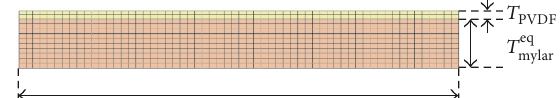
Table 1: Material and geometrical data used in the numerical study.